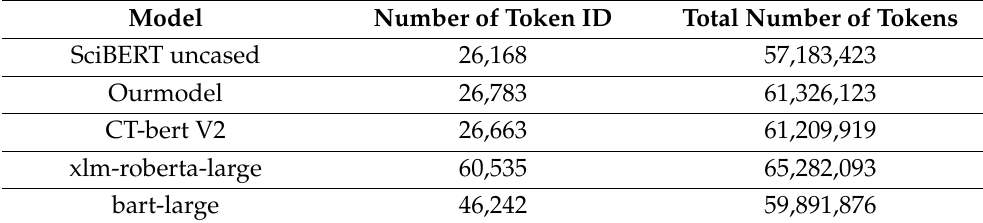
Table 10. Token volume from all